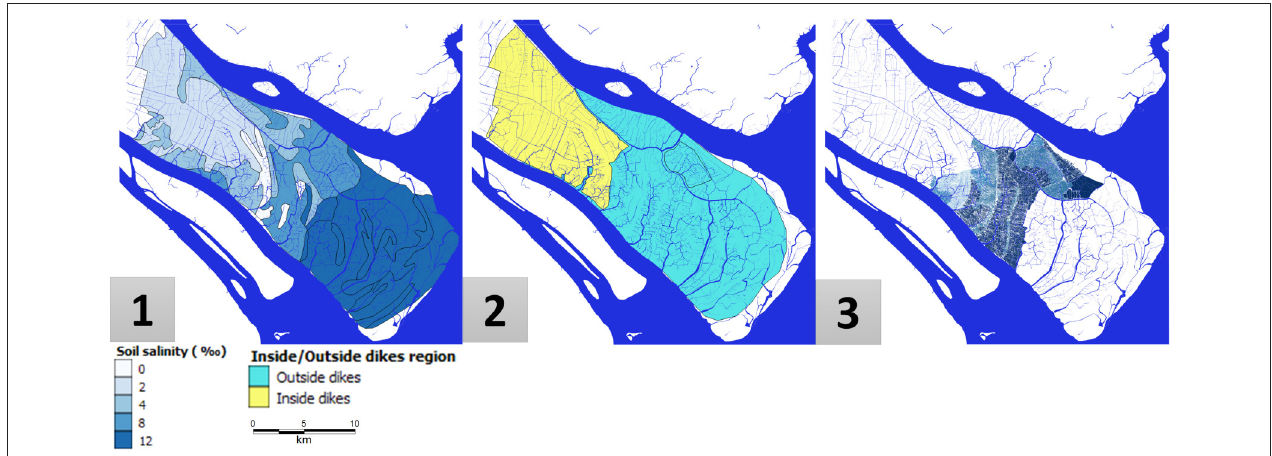
FIGURE 7 | Data for the soil salinity model: (1) Soil salinity map in 2005, (2) Regions protected by dikes in 2010, (3) Soil salinity map in